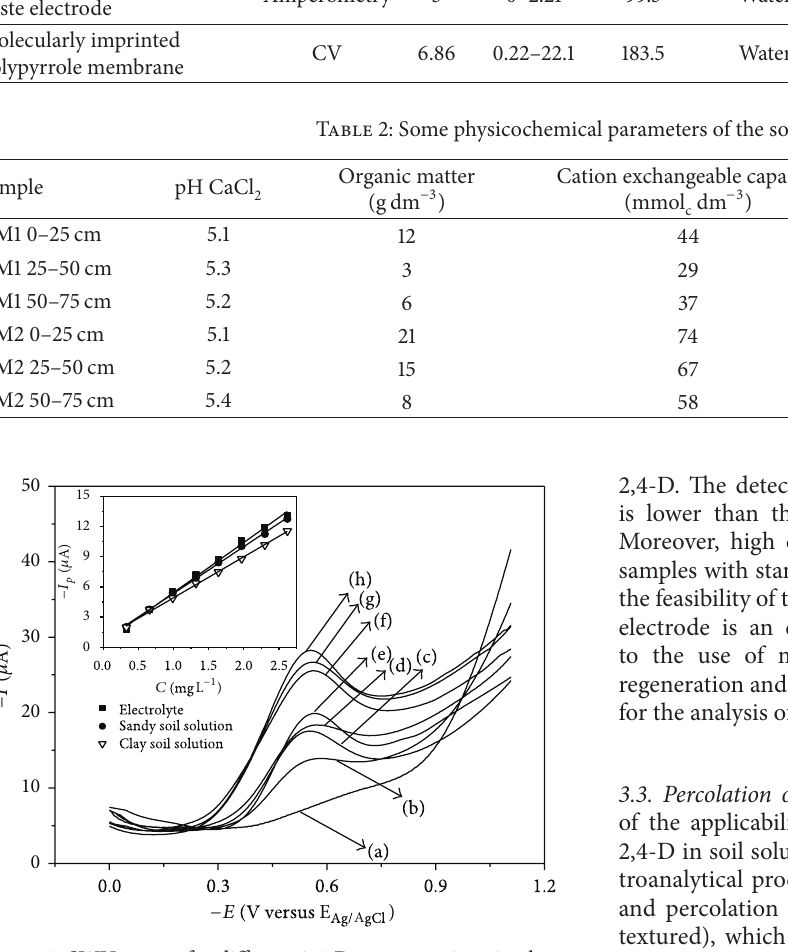
Figure 4: SWV curves for different 2,4-D concentrations in clayey soil solution. Concentration: (a) blank, (b) 0.66, (c) 0.99, (d) 1.32, (e) 1.64, (f) 1.97, (g) 2.30, and (h) 2.62 mg L −1 Parameters: pH 2.0, 𝑓 = 50 s −1 , 𝑎 = 0.50 V, Δ𝐸 𝑖 = 0.03 V, 𝐸 analytical curves in electrolyte ( ◼ ), sandy ( e ), and clayey ( 󳶋 ) soil